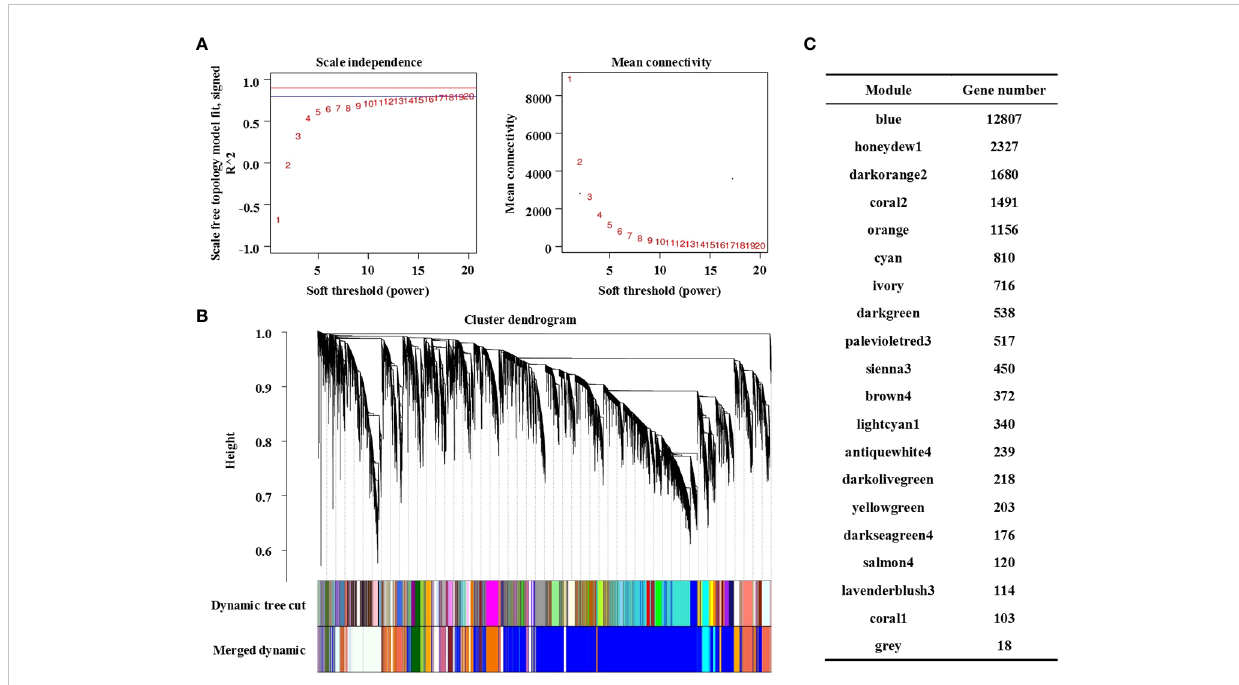
FIGURE 3 Construction of the co-expression network by WGCNA. (A) Soft power curve, the abscissa represents the power value, the ordinate (left) represents the correlation coef fi cient, and the ordinate (right) represents the average connectivity of genes; (B) Gene cluster dendrograms and module division; (C) Distribution of the number of genes in co-expression